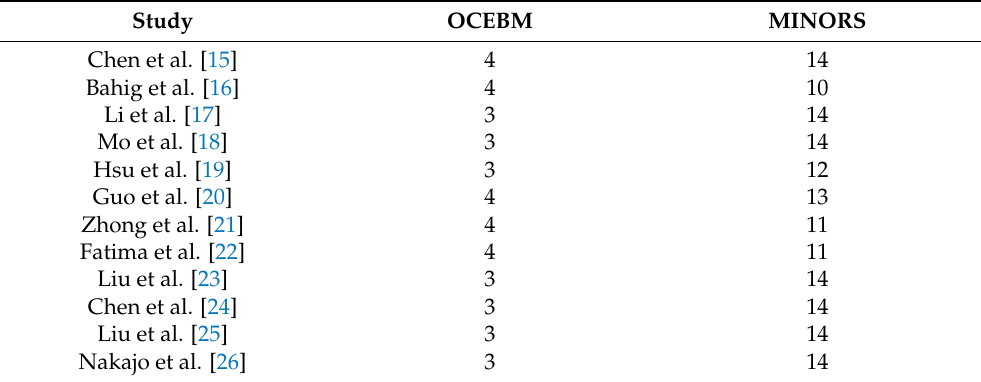
Table 2. Assessment of Quality and Risk of Bias. OCEBM: Oxford Center for Evidence-Based Medicine; MINORS: Methodological Index for Non-Randomized